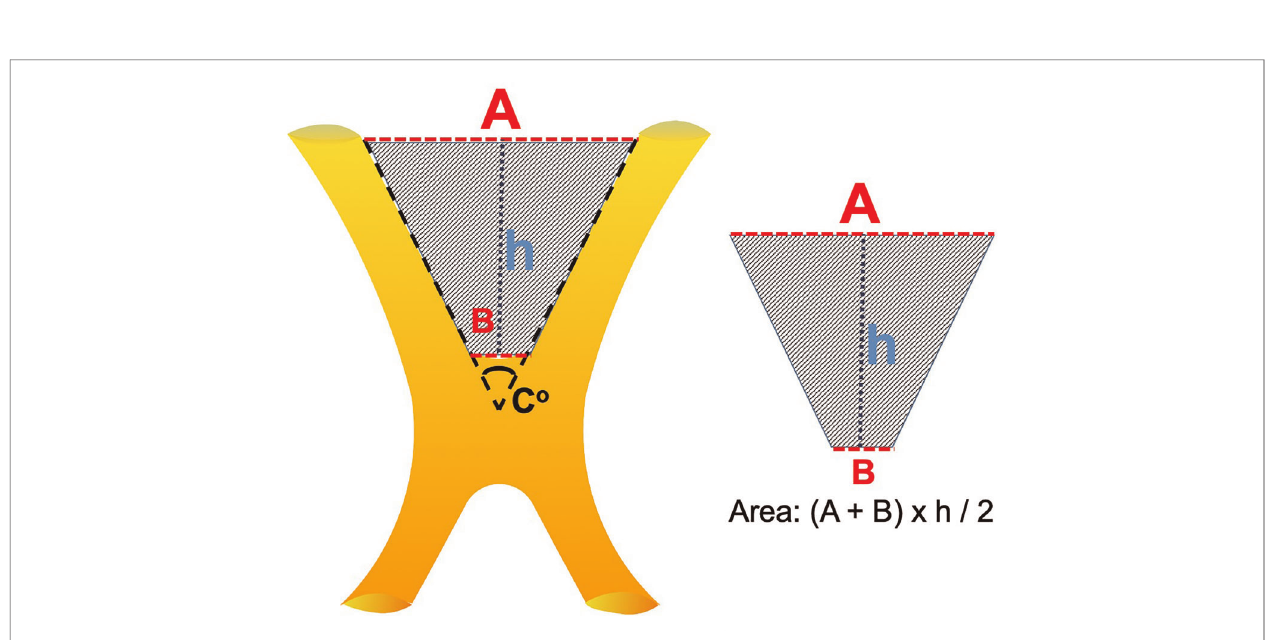
FIGURE 2 | Graphic representation of the prechiasmatic space. h , the distance from the anterior aspect of the optic chiasm to the limbus sphenoidale; A, the distance between the bilateral optic nerves at the entrance to the optic canal; B, the distance between the optic nerves just before they form the optic chiasm. Prechiasmatic area (scanned area) calculated by using the trapezoid area formula: [( A + B )× h